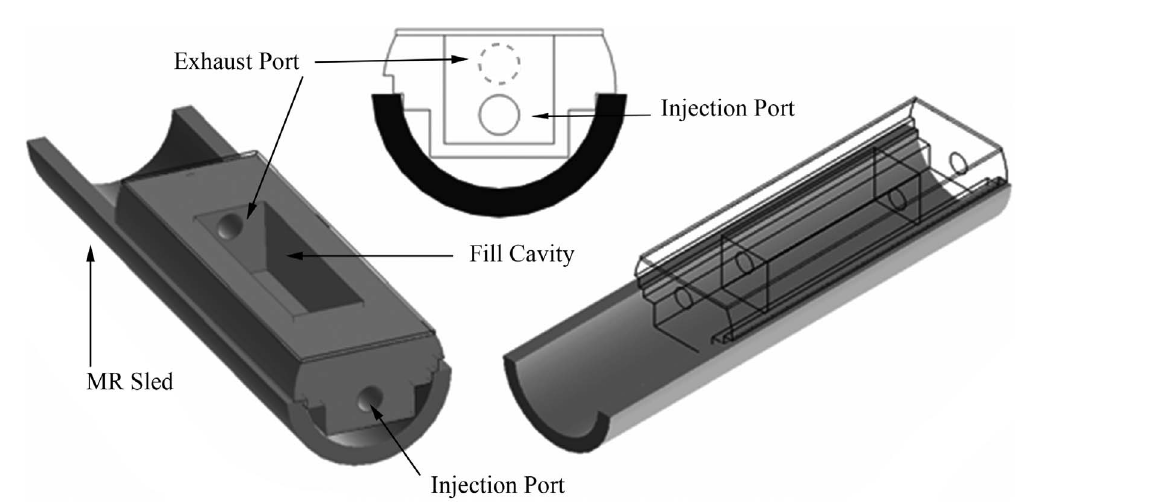
Figure 1. A schematic view of the dynamic chemical phantom structure. The injection and exhaust ports were fitted with catheters to facilitate rapid mixture of reagents at isocenter. A thin acrylic sheet was attached to the top to seal the fill cavity. This top could be removed to allow cleaning after injection. The phantom rested on a sled that allowed convenient removal and insertion of the phantom and included warm circulating water to maintain constant temperature.